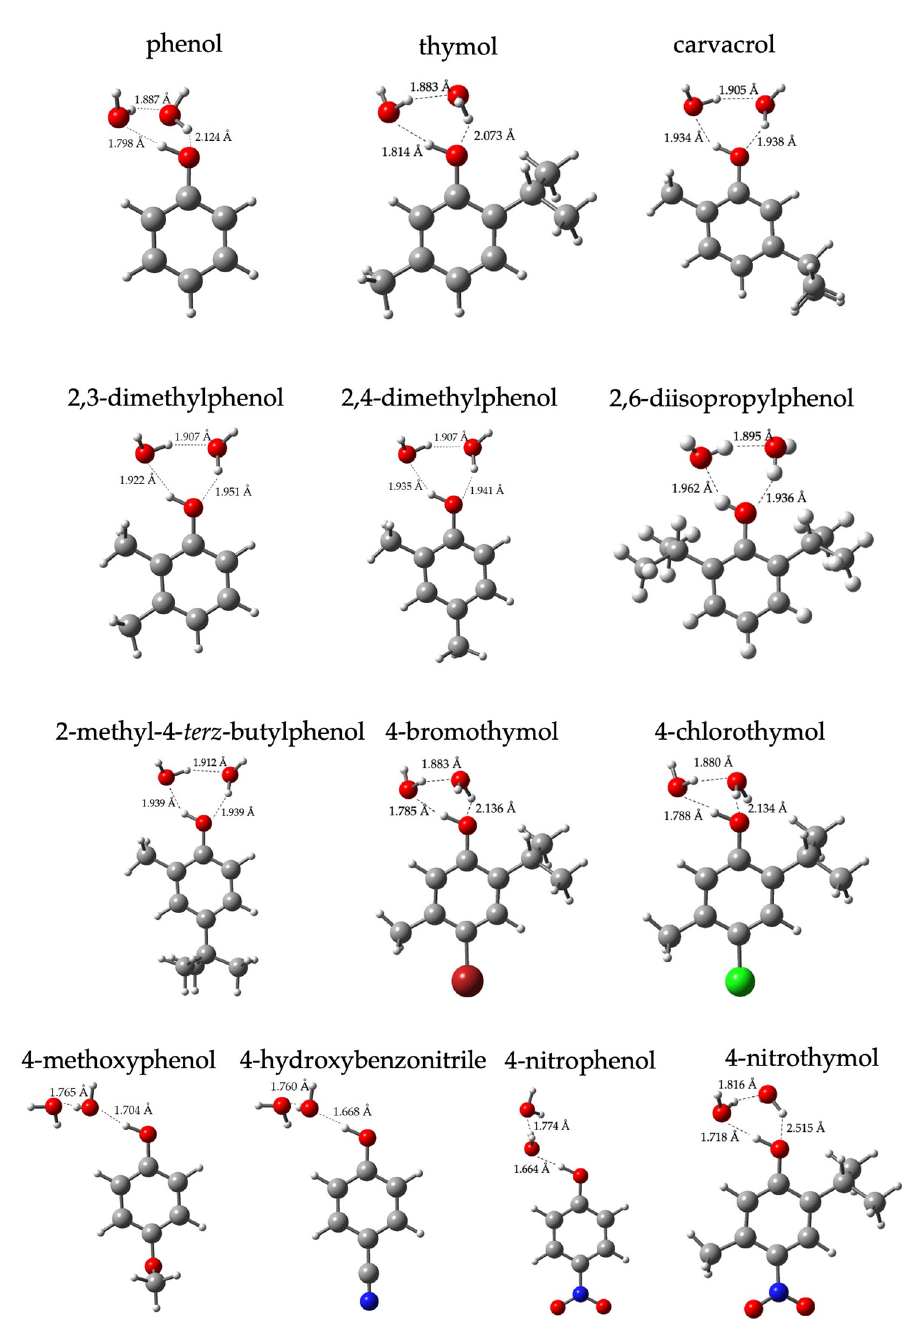
Figure 5. Optimized geometry of phenol derivatives in the presence of two explicit water molecules. Geometry optimization performed with CAM-B3LYP functional, 6-311G+dp basis set and SMD solvation model (C: grey; H: white; O: red; N: blue; Br: dark red; Cl: green).